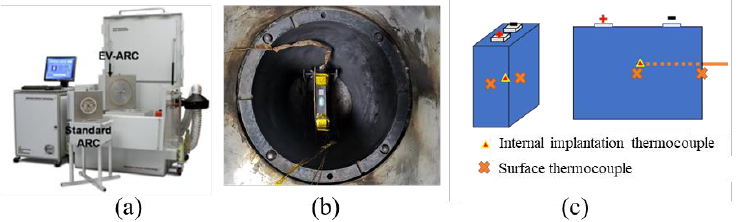
Figure 2. Experimental setup for EV-ARC test. ( a ) EV-ARC; ( b ) EV-ARC chamber; ( c ) Schematic of thermocouple position.